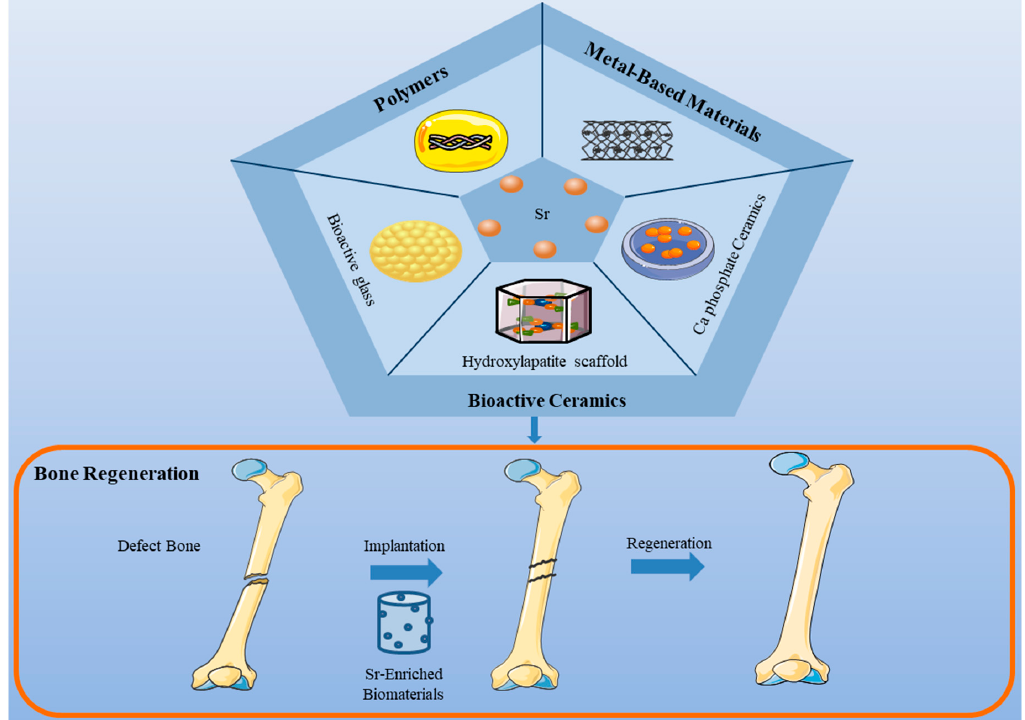
Figure 2. Biomaterials compound with Sr for bone regeneration.